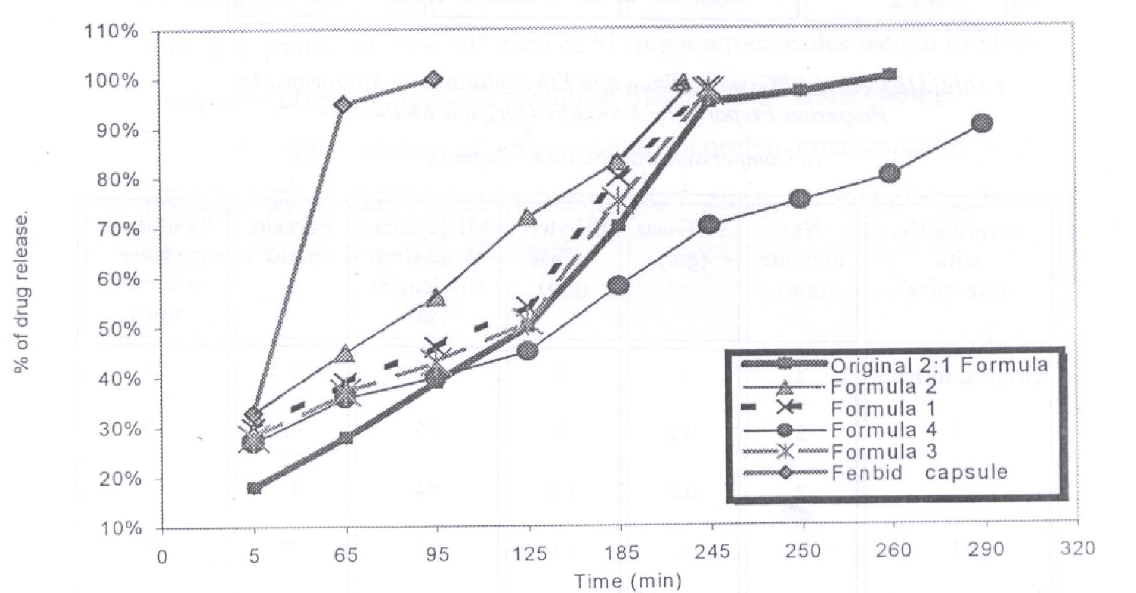
Figure(2): Effect of addition of PEG and ethylcellulose on the release profile of 2:1 4000 core:wall ratio of ibuprofen microcapsules prepared by a modified organic method in comparison with Fenbid ® capsule using pH 6.8 phosphate buffer at